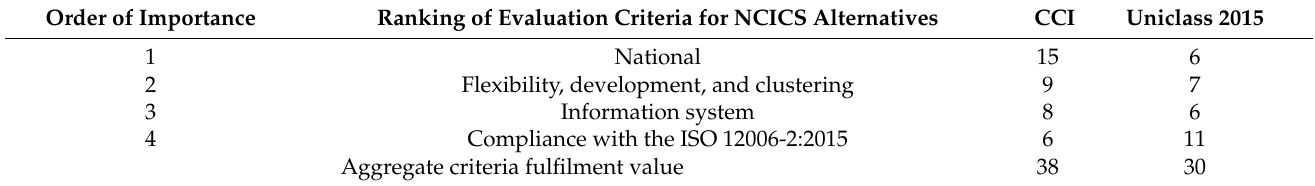
Table 11. Aggregate scores of NCICS evaluation criteria by importance and their compliance with alternatives (in